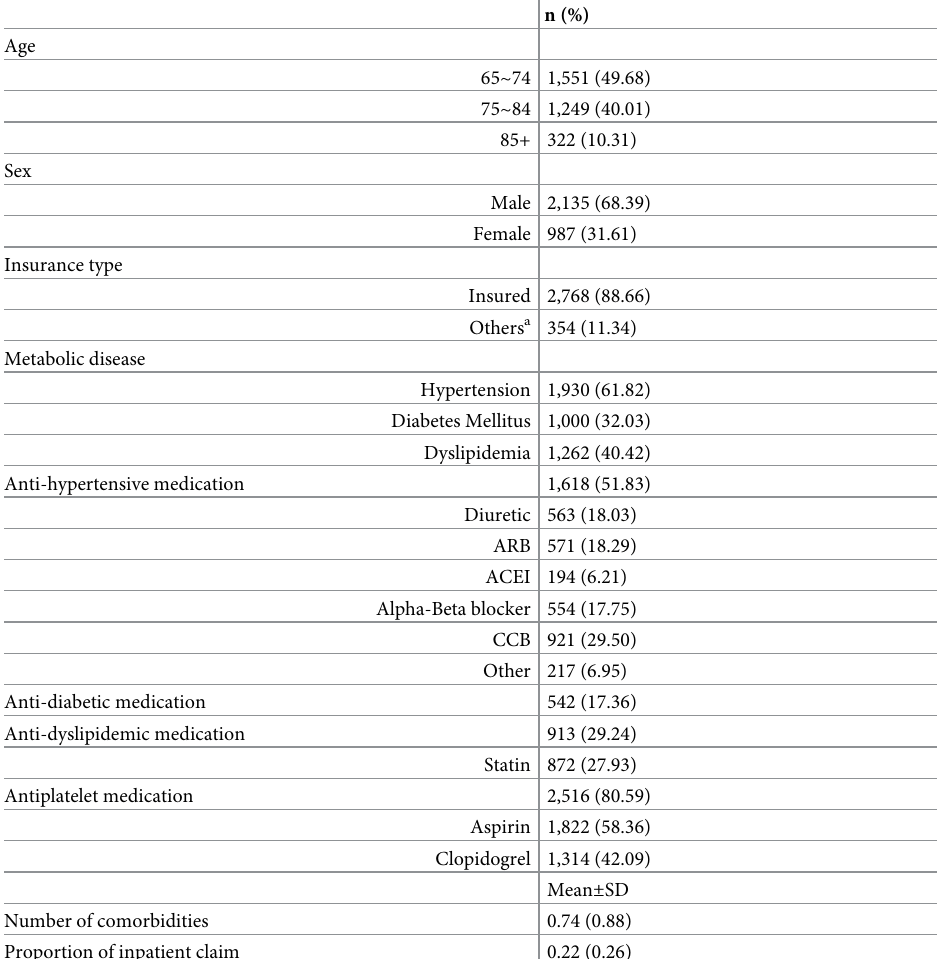
Table 1. Participants characteristics at index date (n =